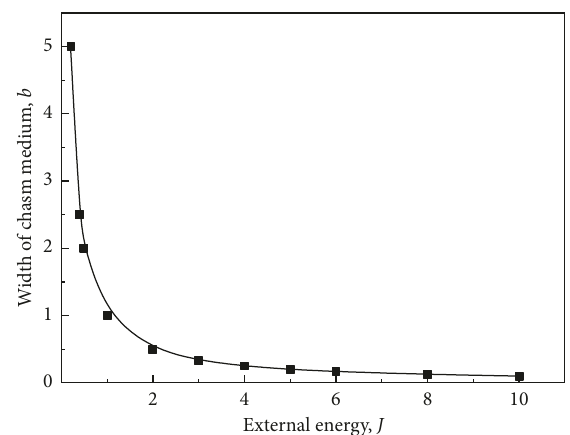
Figure 4: Width of fault medium-outside providing energy